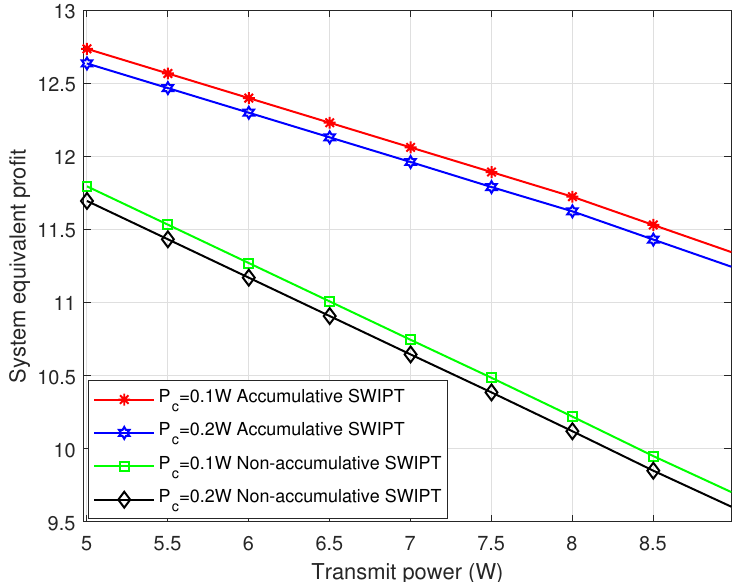
Figure 12. System equivalent profit versus transmitted power for accumulative energy based on SWIPT and non-accumulation energy based on